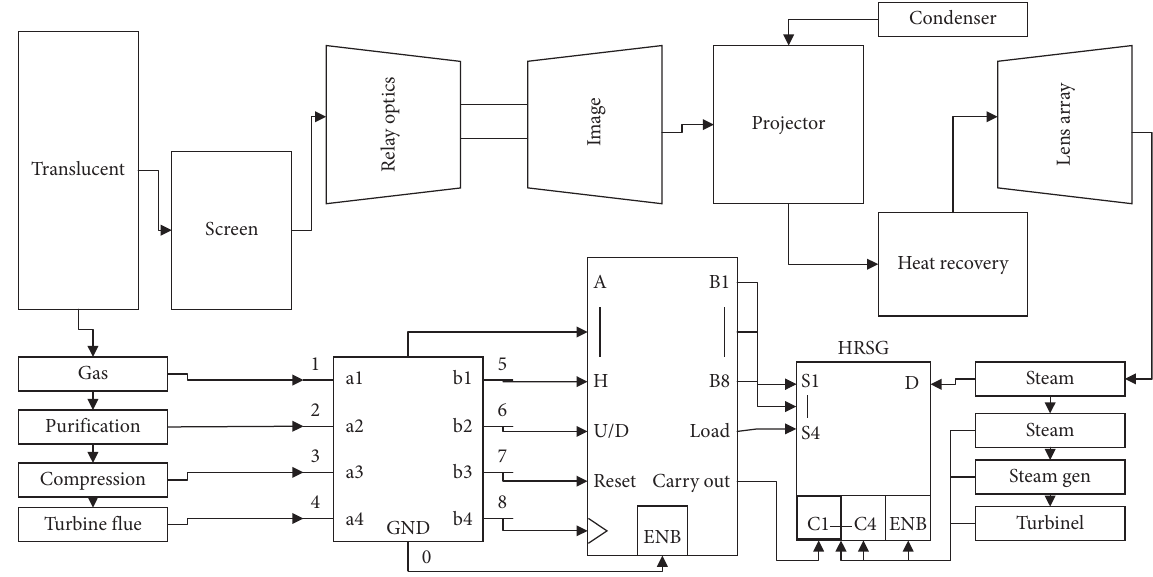
Figure 3: Projection method of air-separation